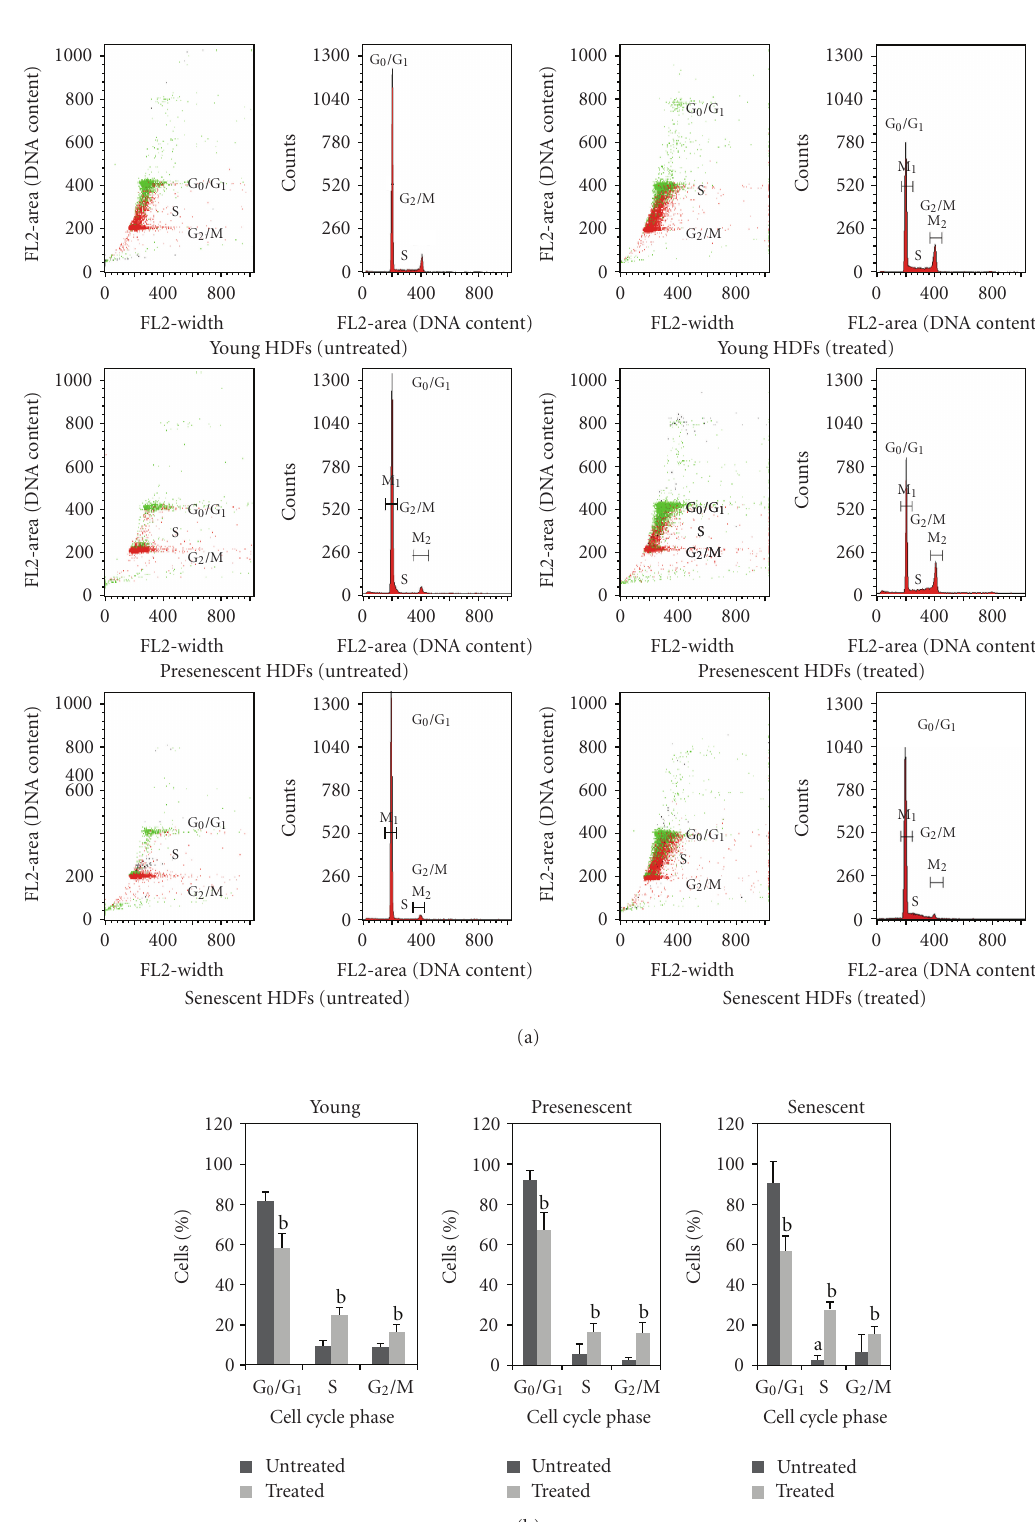
Figure 6: Analysis of cell cycle progression. Flow cytometric analysis of cell cycle progression in young, presenescent, and senescent HDFs (a). Quantitative analysis of cell cycle progression in untreated and TRF-treated HDFs at various stages of cellular ageing (b). Cell population in the S phase was lower in senescent HDFs. Treatment with TRF significantly increased cells in S phase and G 2 /M phase for all stages of cellular ageing of HDFs. In contrast, cell populations in G 0 /G 1 phase decreased significantly with TRF treatment. a Denotes P < . 05 compared to S phase of untreated young HDFs, b P < . 05 compared to untreated HDFs. Data are presented as mean ± SD, n =